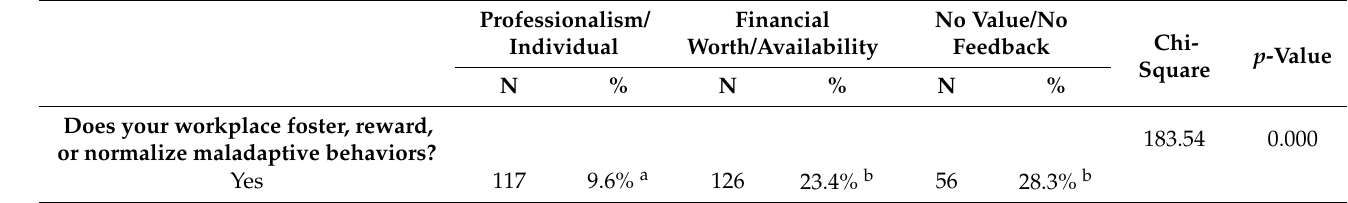
Table 4. Legal profession and mental